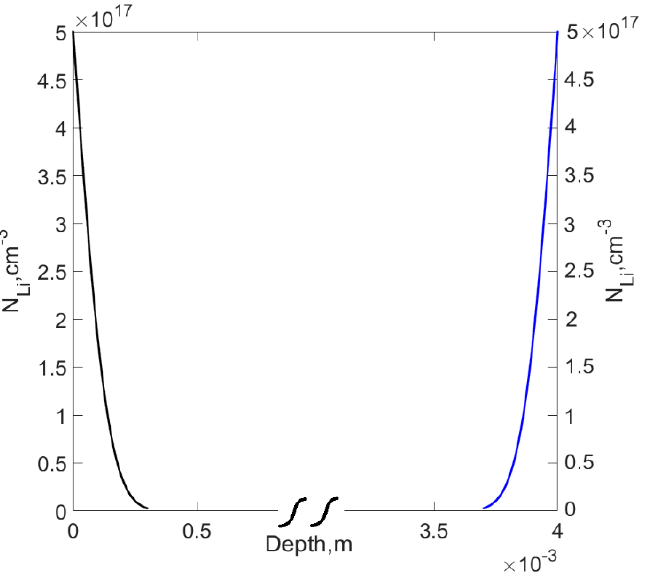
Figure 3. Double-sided diffusion profile of Li atoms into Si, at a temperature T = 420 °C, to the depth of 300 μ m from both sides of the Si crystal.